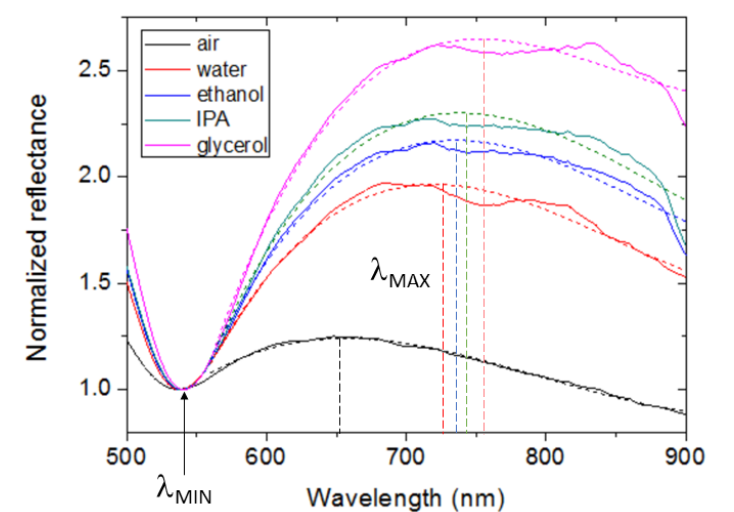
Figure 4. Spectral reflectance curves for different fluids normalized to the reflectance minimum (solid lines) and corresponding third degree polynomial fittings in the 560 – 900 nm wavelength range (dotted lines). Vertical dashed lines indicate the spectral position of the maximum reflectance (λ MAX ) of the fittings for each fluid. λ MIN denotes the reflectance dip wavelength.